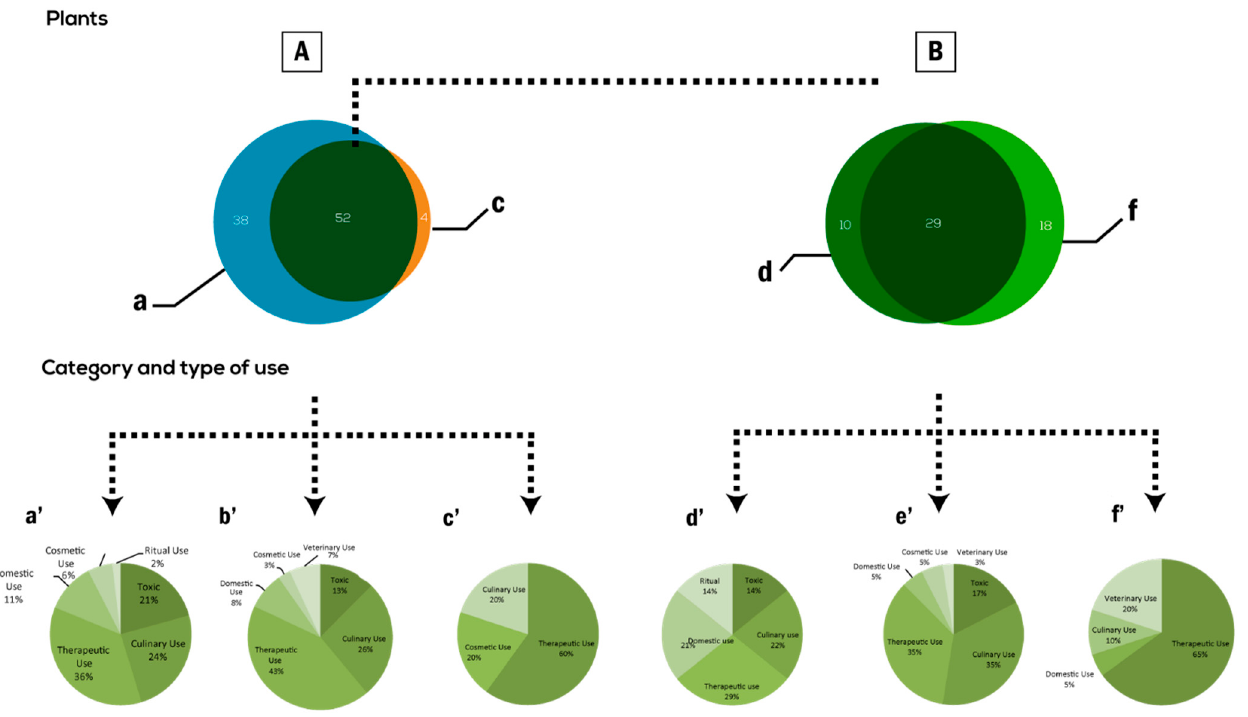
Figure 7. Comparison of ethnobotanical knowledge reported by the respondents in the present study and their forefathers reported by Le Floc’h [13]. ( A ) Venn’s diagram showing the shared ethnobotanical taxa between ( a ) the current community of Ouled Dabbeb and ( c ) their semi-nomadic ancestors reported by Le Floc’h [13]; ( B ) Venn’s diagram showing the shared plant taxa cited as useful by both the respondents in this study and their ancestors reported by the Floc’h [13] with d’: different method of preparation only cited by Le Floc’h [13] ( d ) and d: novel use only cited in this study ( e ); a’, b’, c’, d’, e’ and f’ represent the category and type of uses of taxa in a, a ∩ c, c, d, d ∩ e, and e respectively.